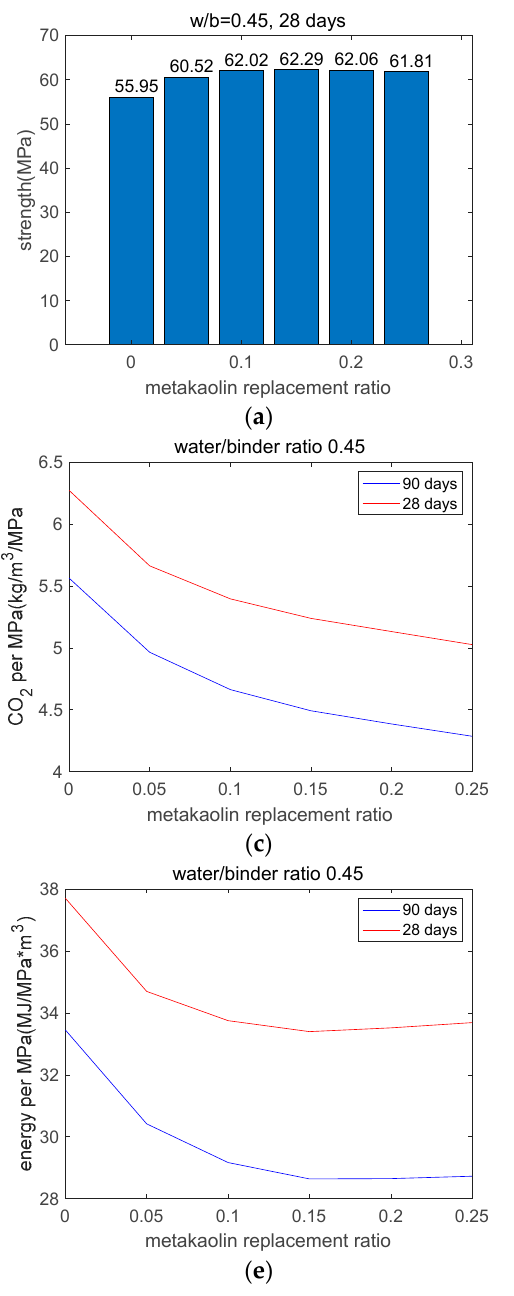
Figure 7. Sustainability analysis of the water/binder ratio 0.45 group. ( a ) strength on day 28 of water/binder ratio 0.45 group. ( b ) strength on day 90 of water/binder ratio 0.45 group. ( c ) normalized CO 2 emissions of water/binder ratio 0.45 group. ( d ) normalized resource consumption of water/binder ratio 0.45 group. ( e ) normalized energy consumption of water/binder ratio 0.45